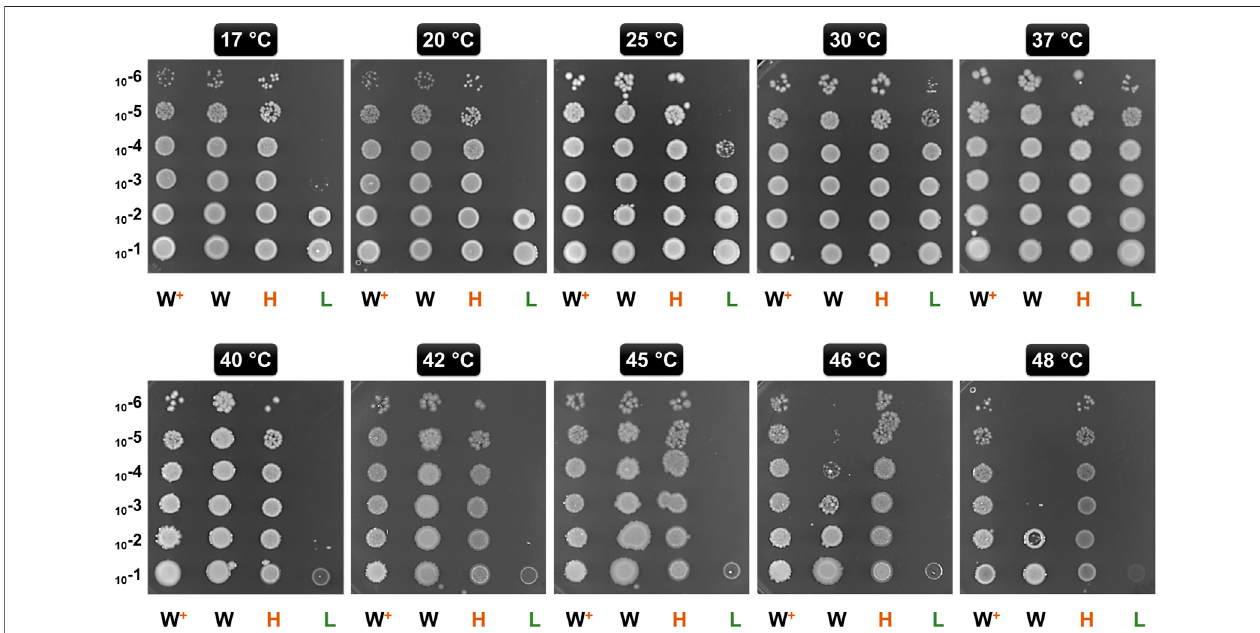
FIGURE2| TemperatureToleranceuponChaperoninOverproduction.Ten-foldseriallydiluted(10 − 1 through10 − 6 )exponentiallygrowingculturesofGL-H t (H),GL-